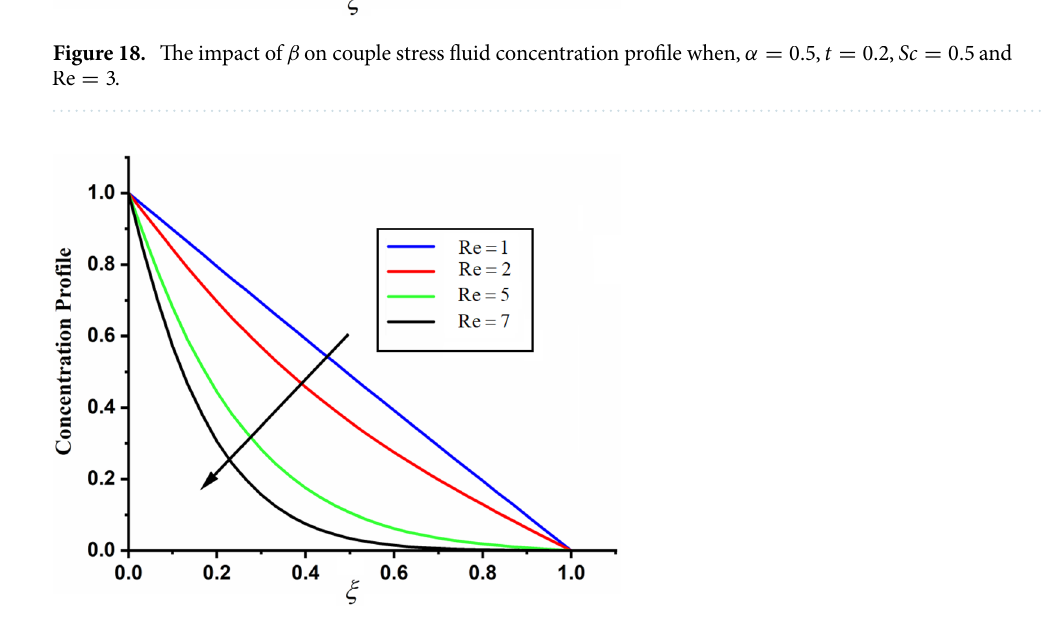
Figure 19. The impact of Re on couple stress fluid concentration profile when α = 0.5 , β = 0.5 , t = 0.2 and Sc = 0.5